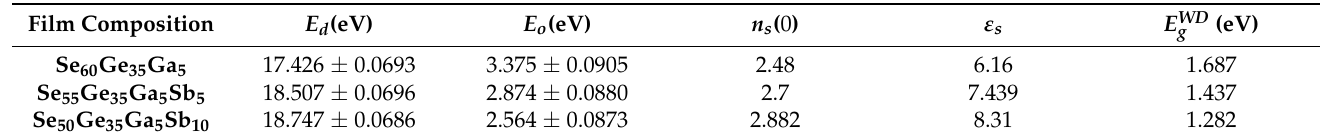
Figure 12. Plots of ( n 2 − 1) − 1 versus ( h υ ) 2 for Se 60 − x Ge 35 Ga 5 Sb x thin films. Table 6. Values of the Wemple–DiDomenico oscillator parameters for Se 60 − x Ge 35 Ga 5 Sb x ( x = 0, 5, and 10) films.